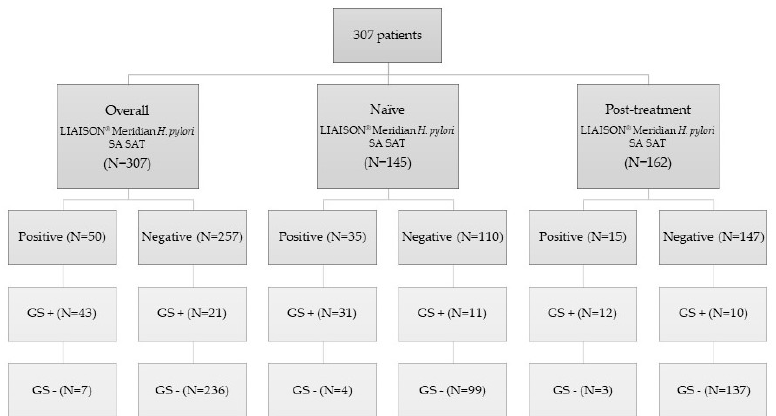
Figure 2. Standards for the Reporting of Diagnostic Accuracy Studies (STARD) flow diagram of the study. N: number of patients included; SAT: stool antigen test; GS+: gold standard positive; GS − : gold standard negative.